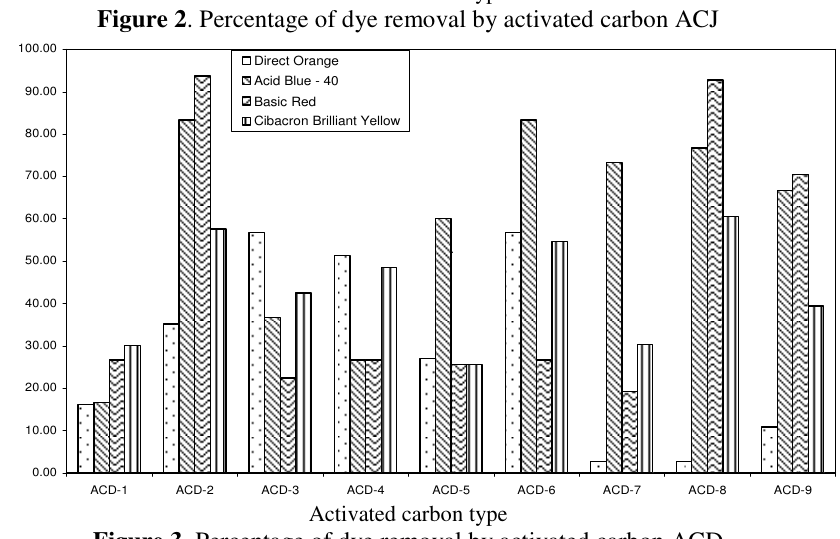
Figure 3 . Percentage of dye removal by activated carbon